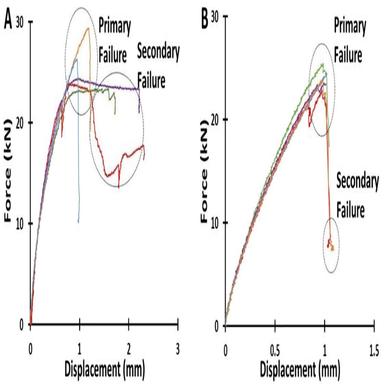
Raw force vs. displacement graphs during compression. (A) Type A configuration, (B) Type B configuration. Each color line is the result from an individual sample plate.